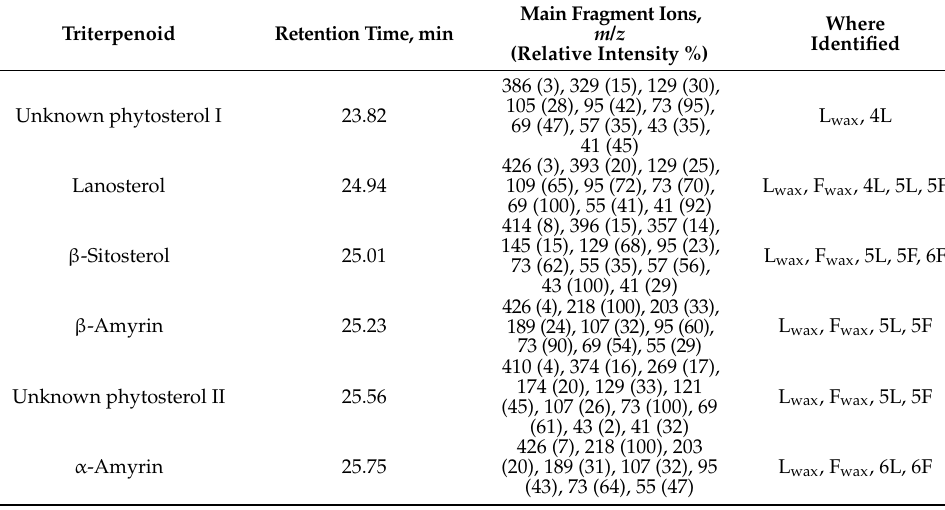
Table 3. GC-MS data of triterpenoids identified in cuticular waxes (L wax , F wax ) and fractions (1–6L and 1–6F) of lingonberry leaves and